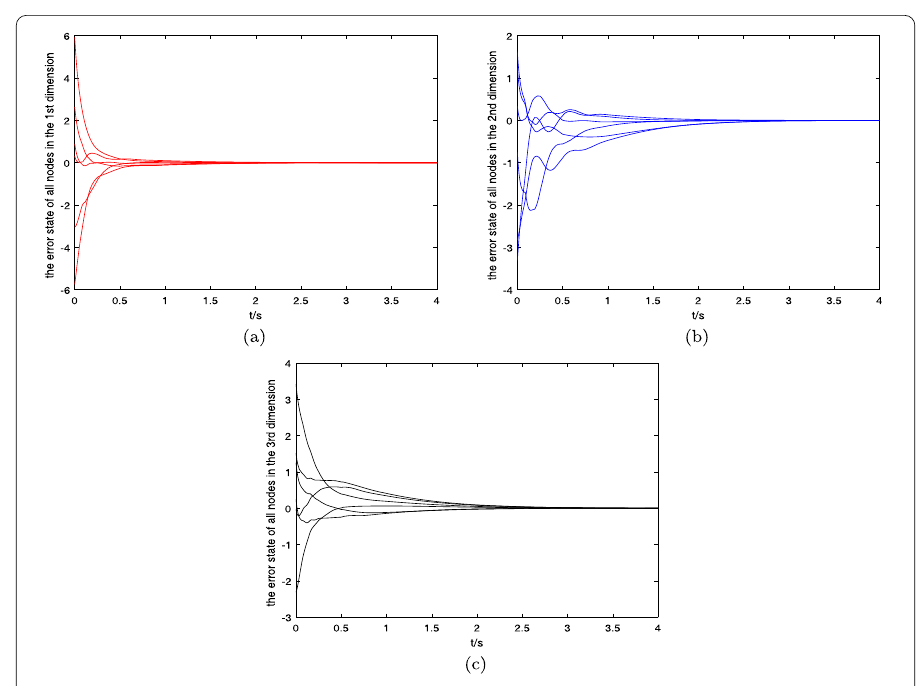
Figure 4 The error state of all nodes in different dimensions with the controller (4)